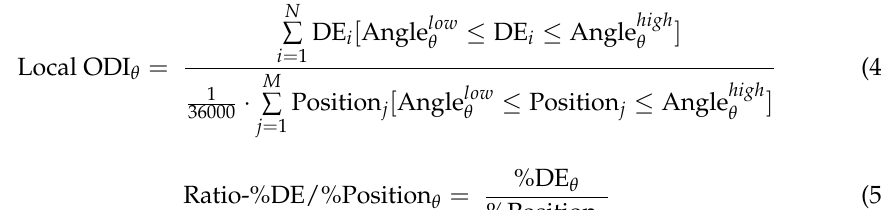
Figure 3. Screenshots of the ‘SleepPos’ app. The ‘Acquisition’ tab ( a ) is used to record the sleep position. Upon clicking the ‘Start’ button, a dialog is prompted ( b ) asking if positional treatment should be applied. Afterwards, the sleep position is acquired and displayed ( c ) on the polar plots as well as the accelerometry values and the time spent on the acquisition. The ‘Recordings’ tab ( d ) shows the details of each acquisition, which include the date, hour of start, and duration. The ‘Re- sults’ tab ( e ) shows a summary of the sleep position for each acquisition. When clicking over each summary, a window prompts ( f ) showing the sleep position with angular resolution, as well as a table with the summarized details of the acquisition.